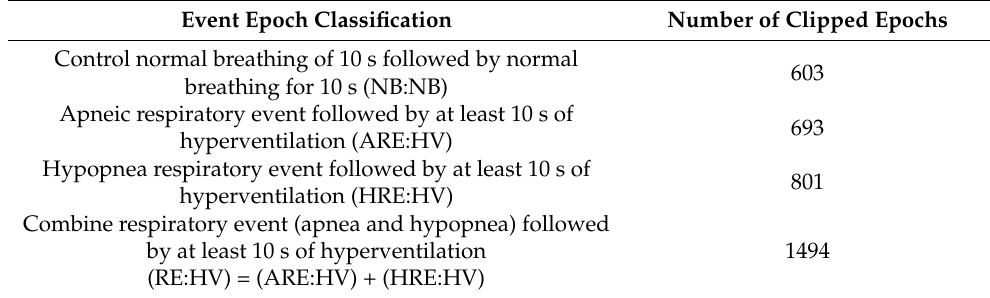
Table 3. Total number and classification of event epochs clipped from all participants in the study.